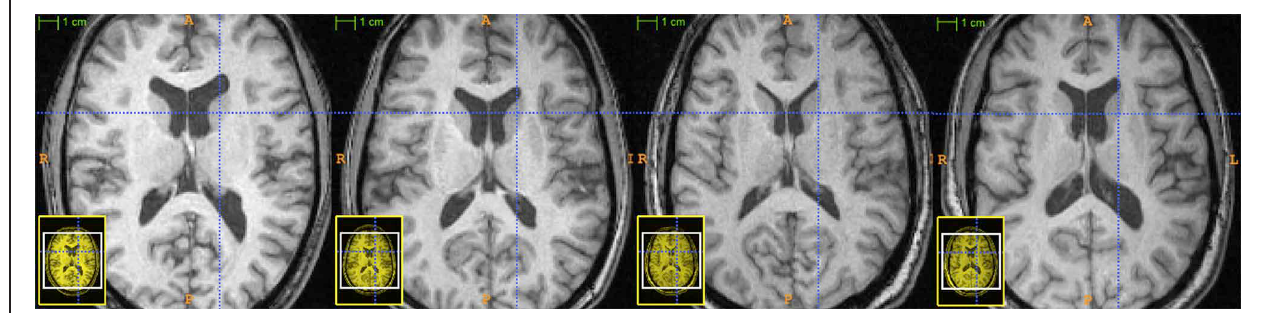
FIGURE 1 | Four TBI survivors’ representative axial scans at the baseline.